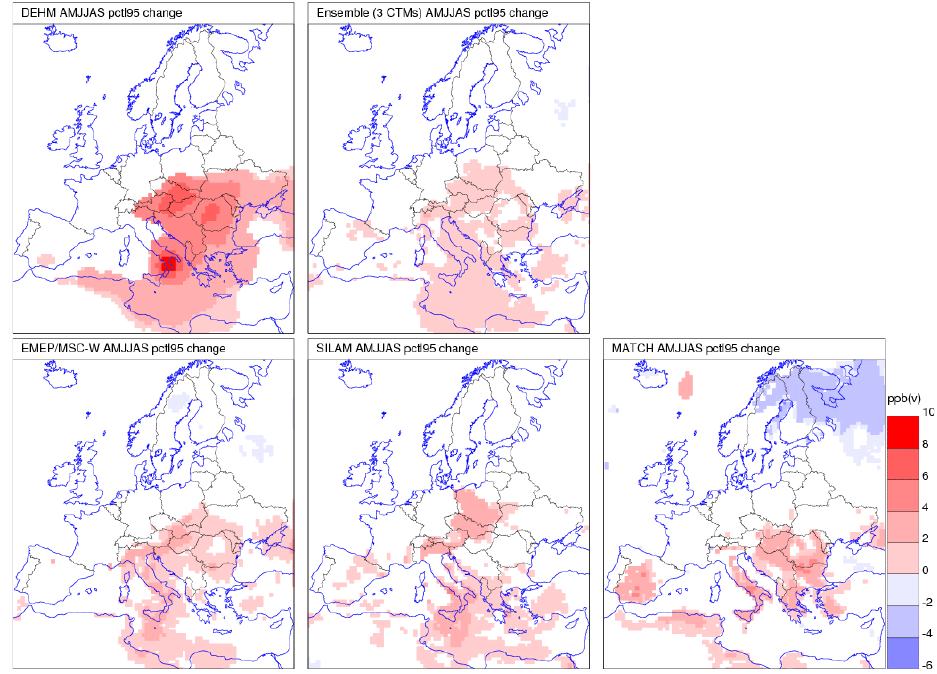
Fig. 11. Simulated April–September change 2000–2009 to 2040–2049 in 95-percentile O 3 concentration at the first model level. Only changes that are statistically significant at the 95% level are plotted. Units ppb(v).